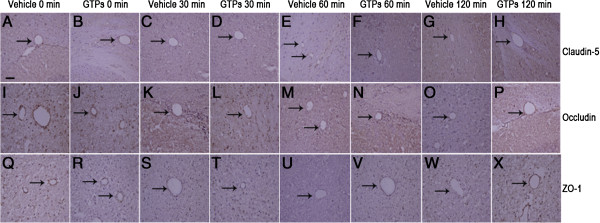
Effects of GTPs on the distribution and expression of claudin-5, occludin, and ZO-1 in ischemic cerebral microvessels were analyzed by immunohistochemistry at 0, 30, 60 and 120 min after ischemia. Representative immunohistochemistry stained graphs of claudin-5 (A, C, E, G), occludin (I, K, M, O), and ZO-1 (Q, S, U, W) at 0, 30, 60, and 120 min after ischemia in the vehicle group; graphs of claudin-5 (B, D, F, H), occludin (J, L, N, P), and ZO-1 (R, T, V, X) at 0, 30, 60, and 120 min after ischemia in the GTPs-treated group. Arrows show cerebral microvessels. Scale bar = 10 μm.